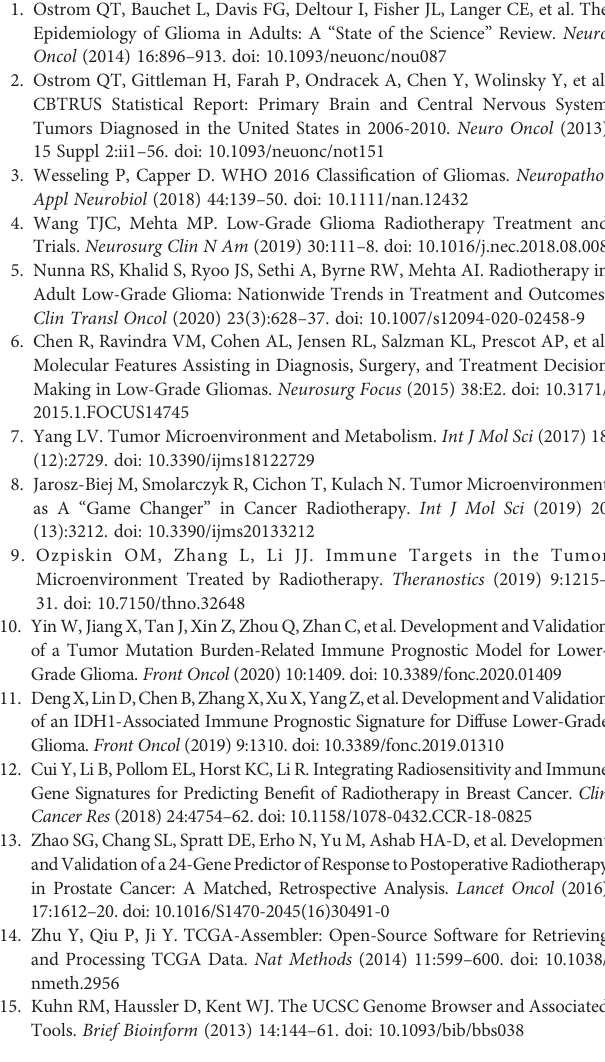
Supplementary Figure 1 | Survival curves plot for stromal score, immune score and ESTIMATE score. Supplementary Figure 2 | Lasso Cox analysis.